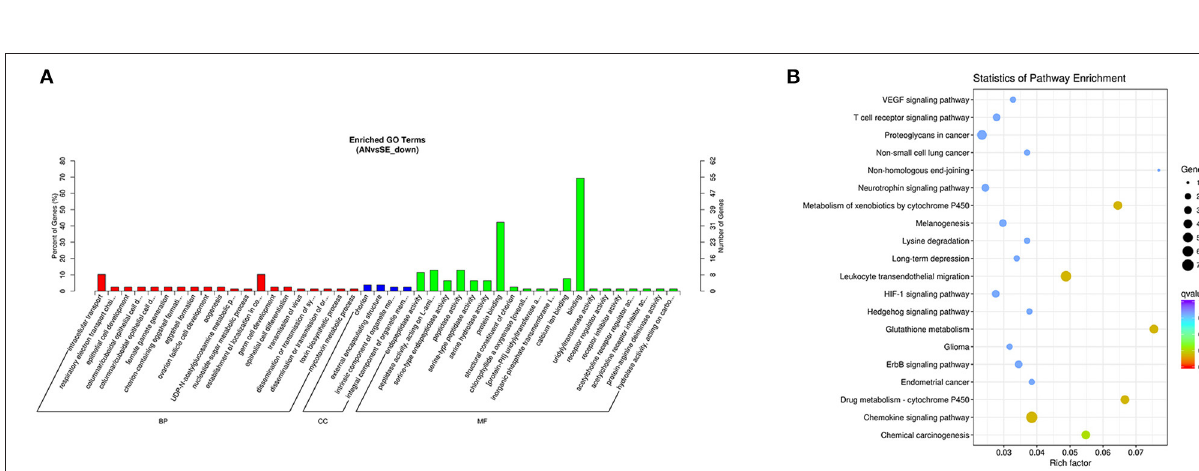
FIGURE 8 | Top annotated GO terms (A) and KEGG pathways (B) of downregulated DE mRNAs.